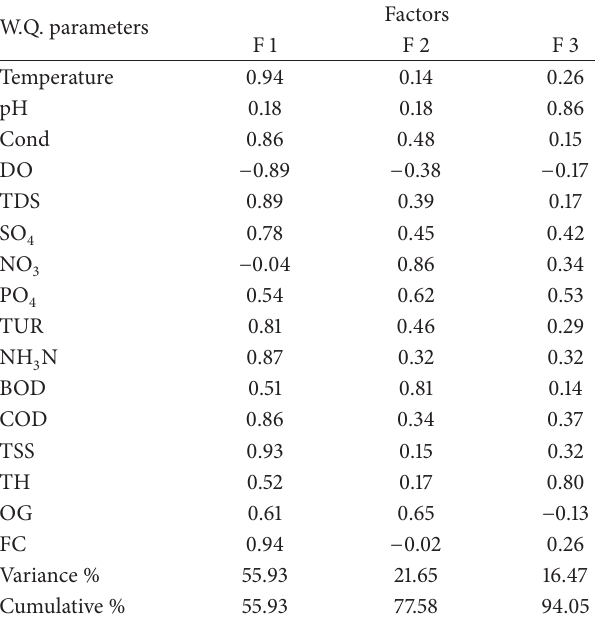
Table 1: The factor loadings after varimax rotation of the water quality